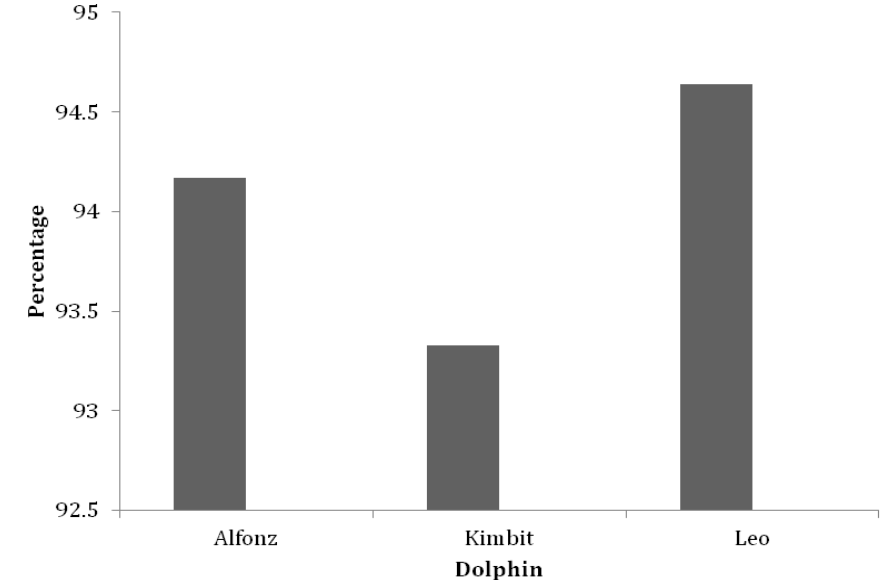
Figure 1. Percentages of correct “vary” responses for each dolphin across all test